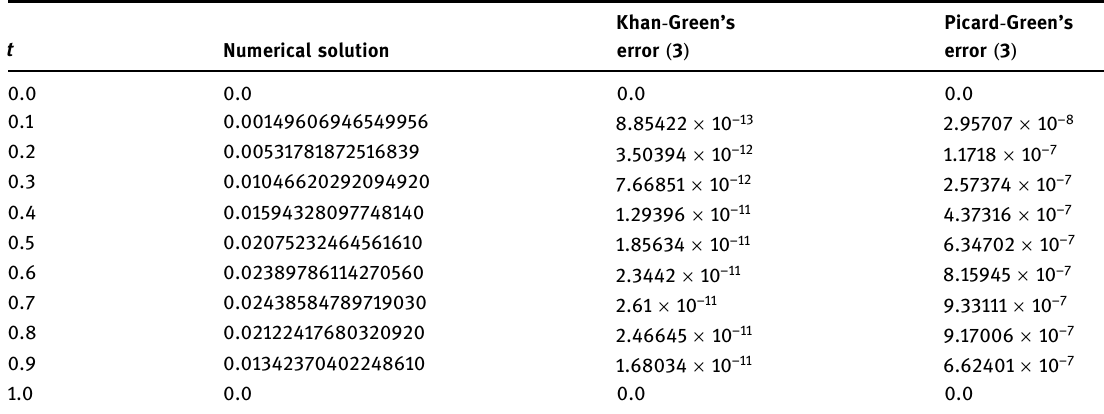
Table 2: Absolute errors ( n ) of Example